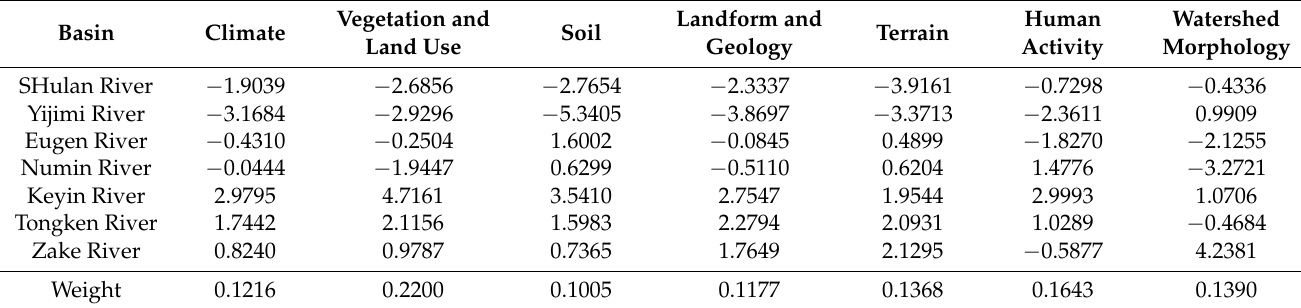
Table 3. Weight of climate and underlying surface factors for physical similarity in the Hulan River Basin. Basin